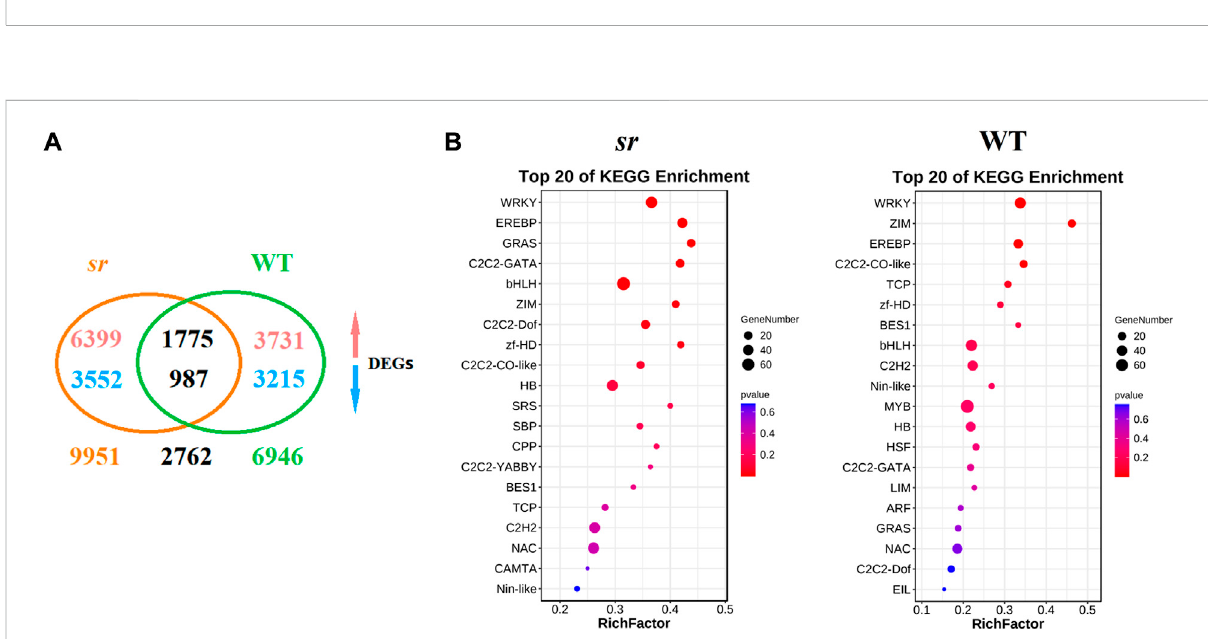
FIGURE 3 DEGidenti fi cationandenrichmentanalysisbetweensusceptibleWTandresistantsrafterPc. (A) Intotal,6,945and9,951differentiallyexpressed genes(DEGs)wereidenti fi edfromWTandsr,respectively,and2,762DEGswerecommonlyidenti fi edinbothlines.Theupwardarrowrepresentsthe upregulated expression. The downward arrow represents the downregulated expression. (B) Enrichment analysis of upregulated TF DEGs between ChinesecabbagelinesWTandsrafterPcinfection.Togaininsightsintothe148 TFfamiliesinresponsetoPcinfection,enrichmentanalysiswas performed using all TF DEGs in the two lines. Among all these TF families, the WRKY family was most signi fi cantly enriched both in WT and sr. The enrichment analysis was performed by the ggplot2 package